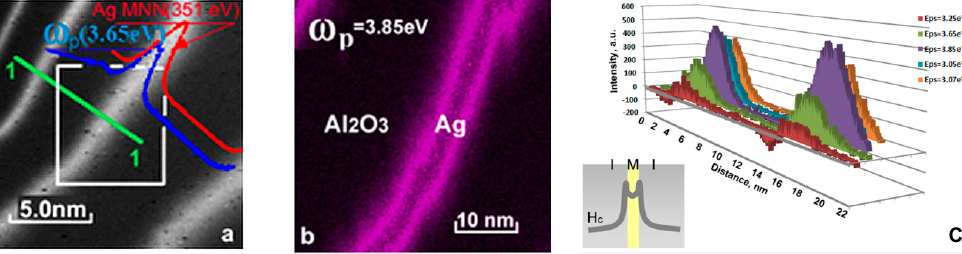
ω p ( c ), δ SPP —depth of plasmon-polariton transboundary penetration. Coatings 2018 , 8 , x FOR PEER REVIEW